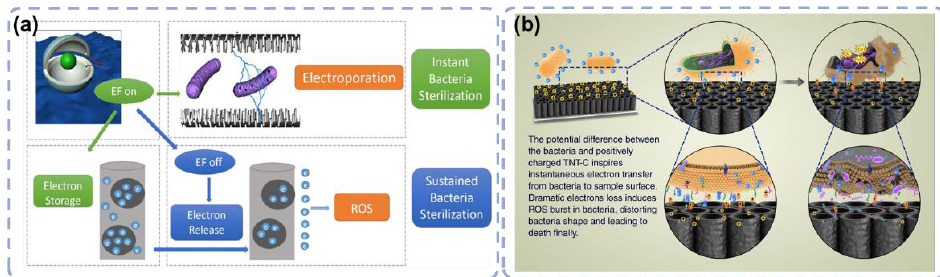
Figure 7. Electrical functionalization to endow the surface with antibacterial properties. ( a ) The first study to discover ZnO nanowires has gained sustained bacteria killing ability after AC tuning, which is different from electroporation when AC is applied to the nanowires. Reprinted with permission from ref [98]. Elsevier, 2017. ( b ) The systematic study to verify the electrical functionalization of TiO 2 nanotubes by DC to endow them with antibacterial properties. Reprinted with permission from ref [99]. Springer Nature, 2018.